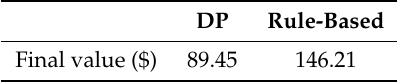
Figure 9. The battery state of charge in scenario 2 ( a ) the DP approach; ( b ) the rule-based method. Table 3. The final value in simulation